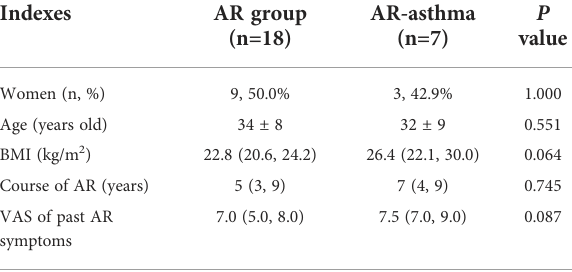
TABLE 1 Comparison of baseline characteristics between the AR group and AR-asthma group.